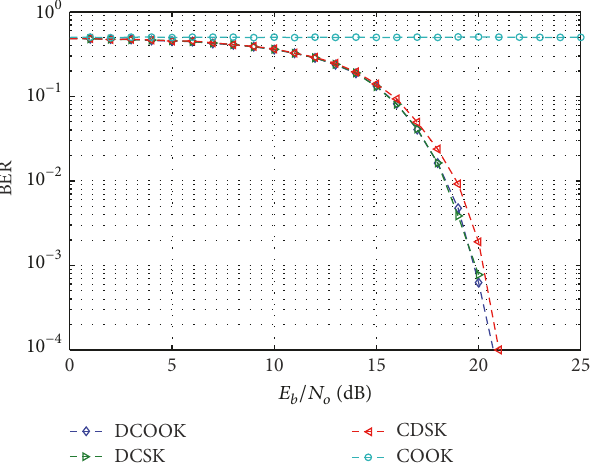
Figure 16: BER performance of DCOOK scheme versus COOK, DCSK, and CDSK schemes at 𝑀 = 700